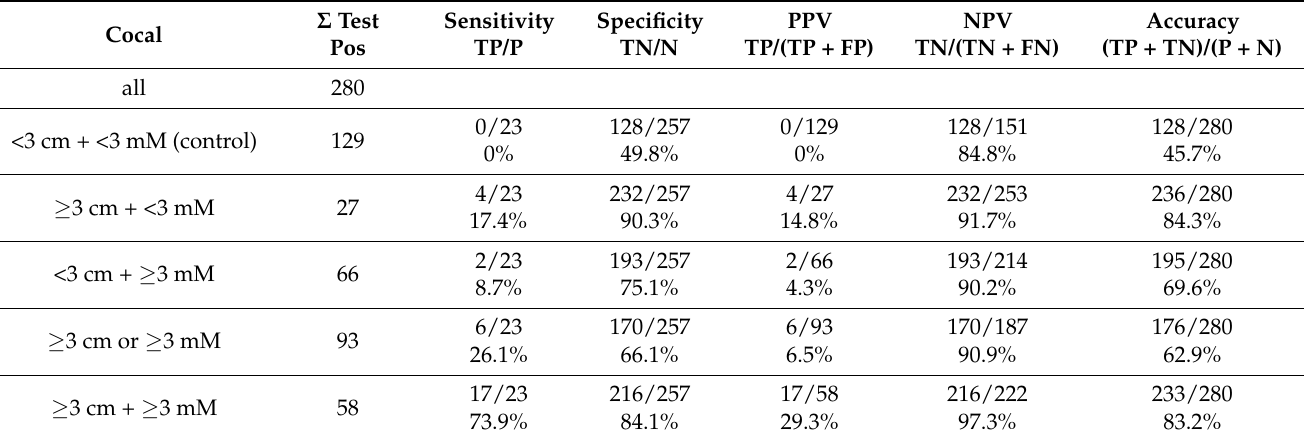
Table 4. The positive 3 + 3 criterion, large lesion and severe hypercalcemia, predicts presence of MPC. p = has cancer = 23; n = has no cancer =